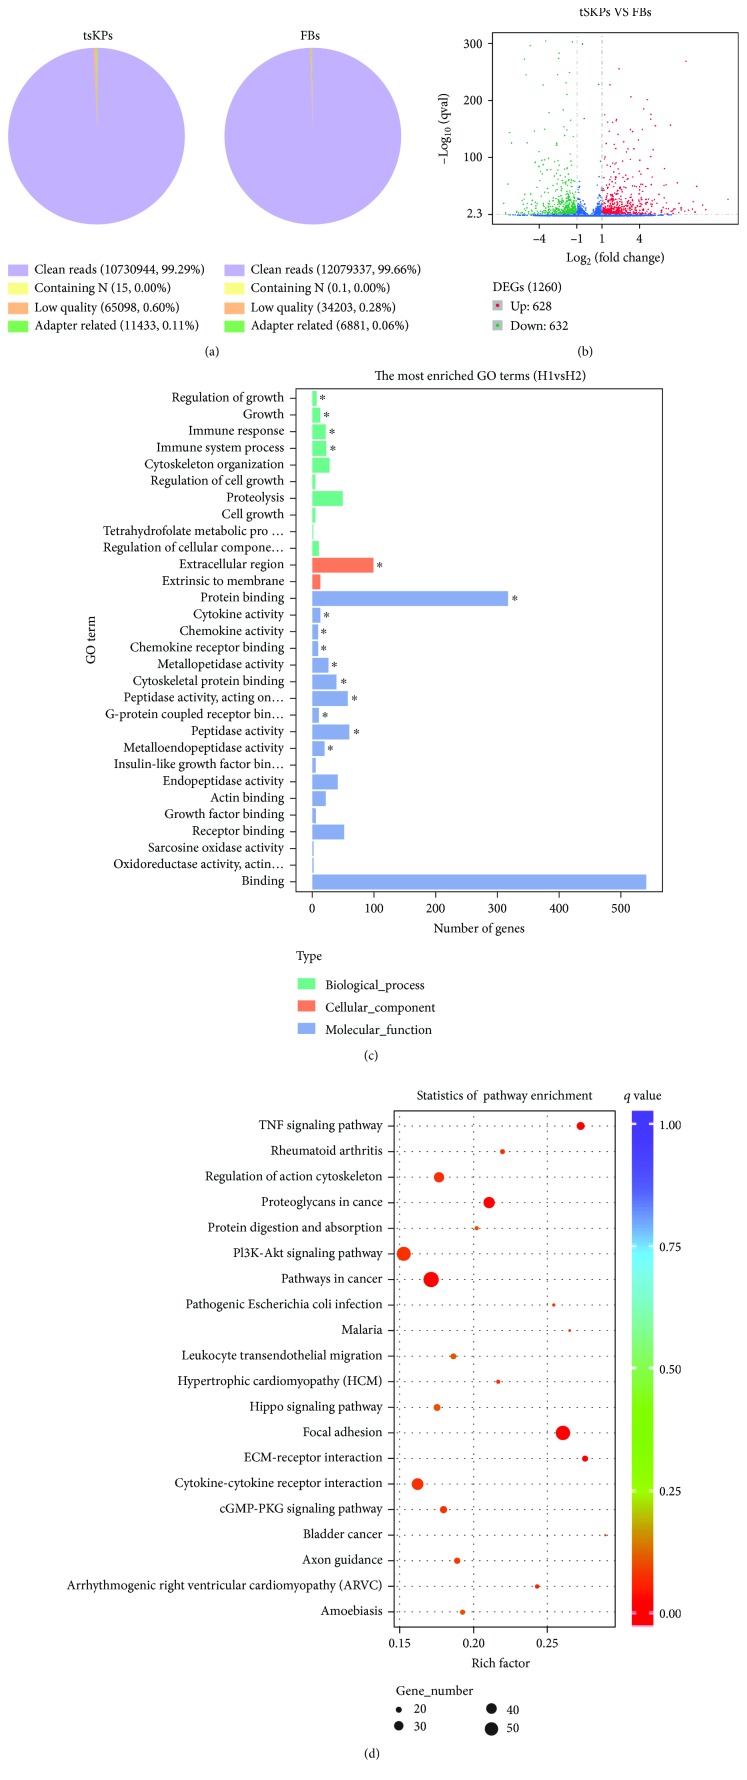
Results of RNA-seq of tSKPs and FBs. (a) Classification of raw reads in tSKPs and FBs. (b) Scattered plot of DEGs identified between tSKPs and FBs. (c) The top 30 enriched GO terms in the three main domains: biological process (10), cellular component (2), and molecular function (18). ∗Significantly enriched GO term. (d) Scattered plot of DEGs enriched KEGG pathways.